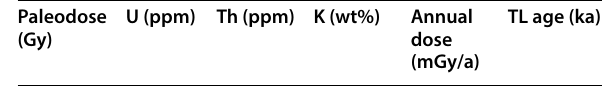
Table 2 Results of TL dating for Y8 lava Paleodose U (ppm) Th (ppm) K (wt%) Annual (Gy)